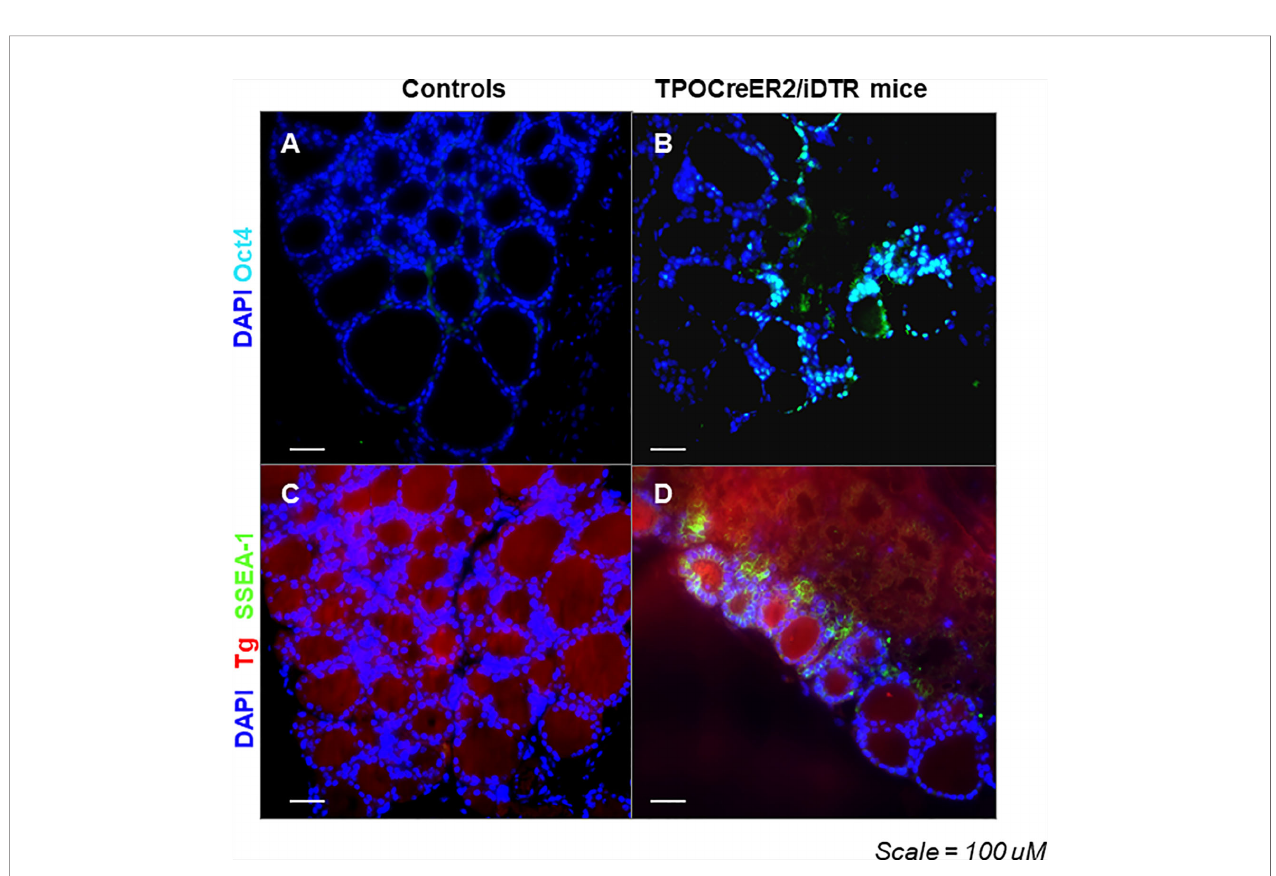
FIGURE 6 | Expression of Oct4 and Ssea-1 in the thyroid glands from TPOCreER2/iDTR mice: (A, B) Representative images of positive immunostaining for expression of Oct4 (light blue) in TPOCreER2/iDTR mice injected with TM/DT for 2 weeks (B) compared to a negative control (A) . (C, D) Representative image of immunostaining for expression of Ssea-1 (green) and Tg (red) in TPOCreER2/iDTR mice injected with TM/DT for 2 weeks (D) compared with control thyroid (C)